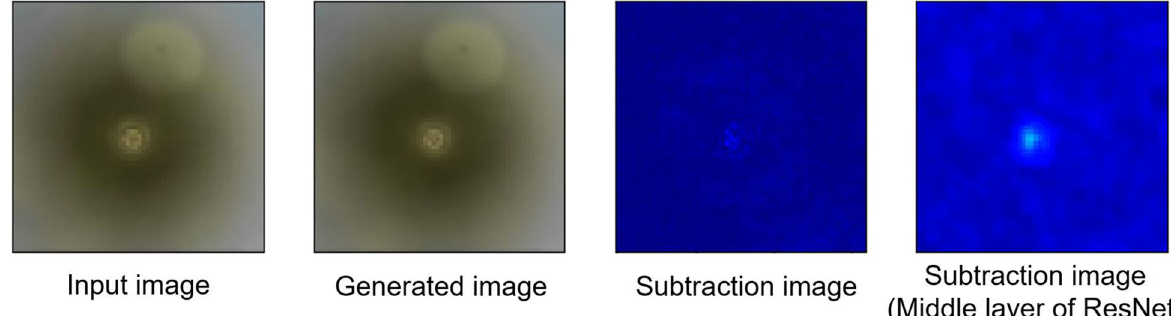
Fig. 12 Experimental results of normal new cast iron pipe (VAE)